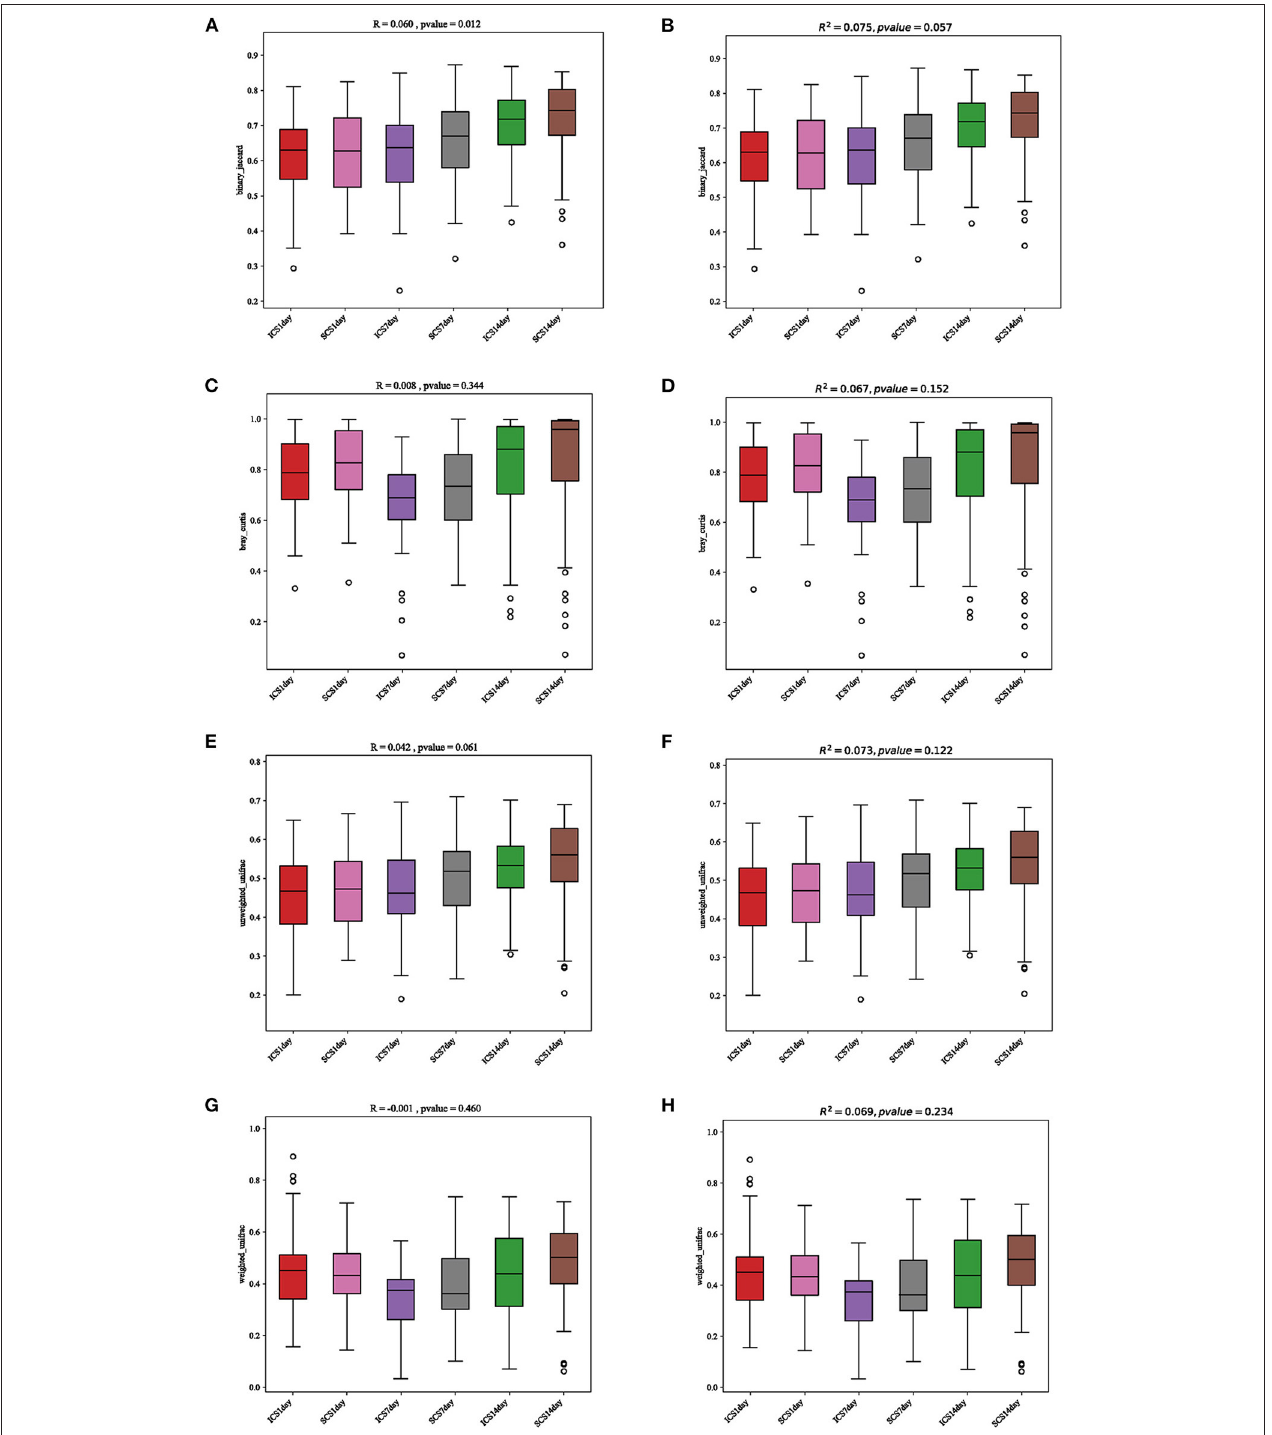
FIGURE 9 | Statistical analysis results for PCA and PcoA. (A) Anosim statistical analysis of the results, analyzed by the binary Jaccard algorithm. (B) PERMANOVA statistical analysis of the results, analyzed by the binary Jaccard algorithm. (C) Anosim statistical analysis of the results, analyzed by the Bray-Curtis algorithm. (D) PERMANOVA statistical analysis of the results, analyzed by the Bray-Curtis algorithm. (E) Anosim statistical analysis of the results, analyzed by the unweighted UniFrac algorithm. (F) PERMANOVA statistical analysis of the results, analyzed by the unweighted UniFrac algorithm. (G) Anosim statistical analysis of the results, analyzed by the weighted UniFrac algorithm. (H) PERMANOVA statistical analysis of the results, analyzed by the weighted UniFrac algorithm. The results showed no differences between the two groups, and there was no significant difference before or after treatment.